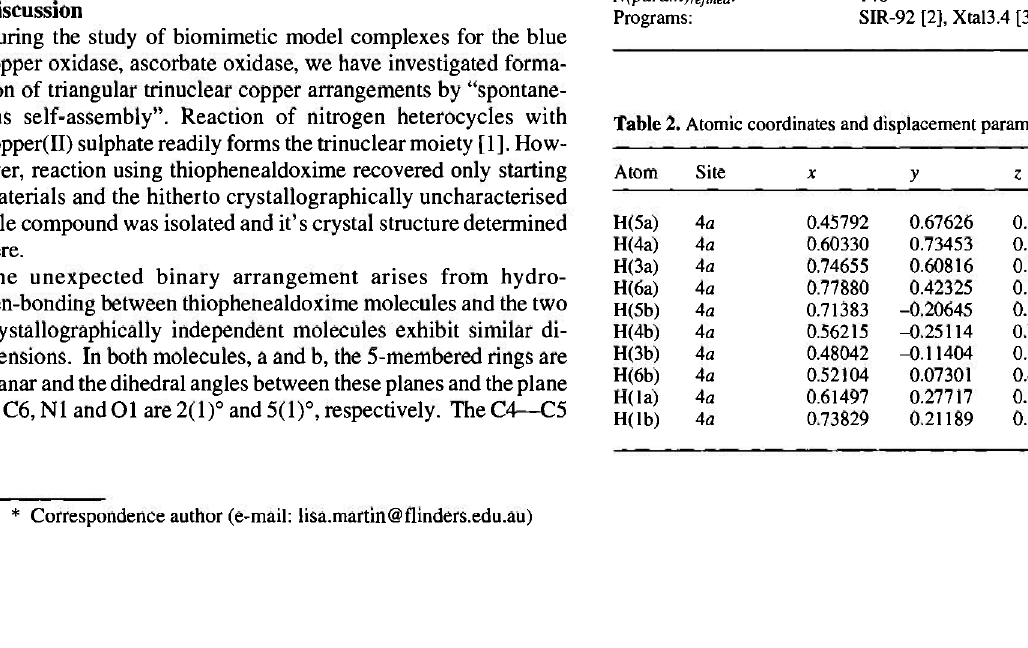
Table 2. Atomic coordinates and displacement parameters (in Ä 2